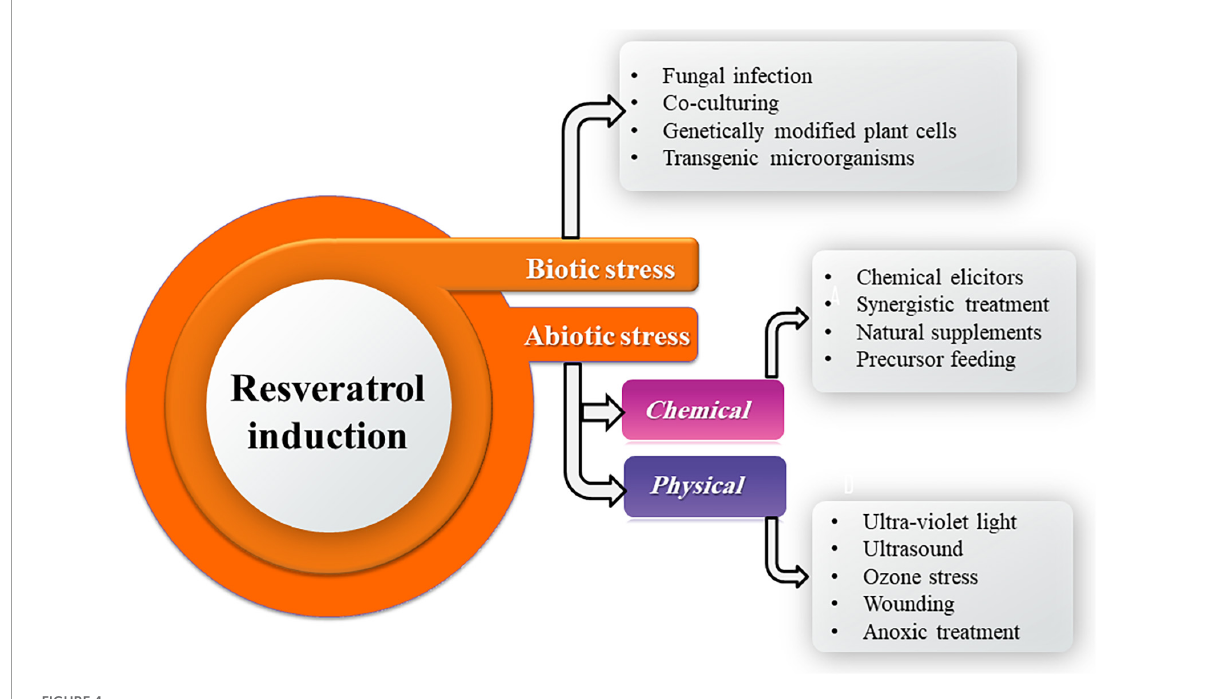
FIGURE4 Different elicitors for resveratrol